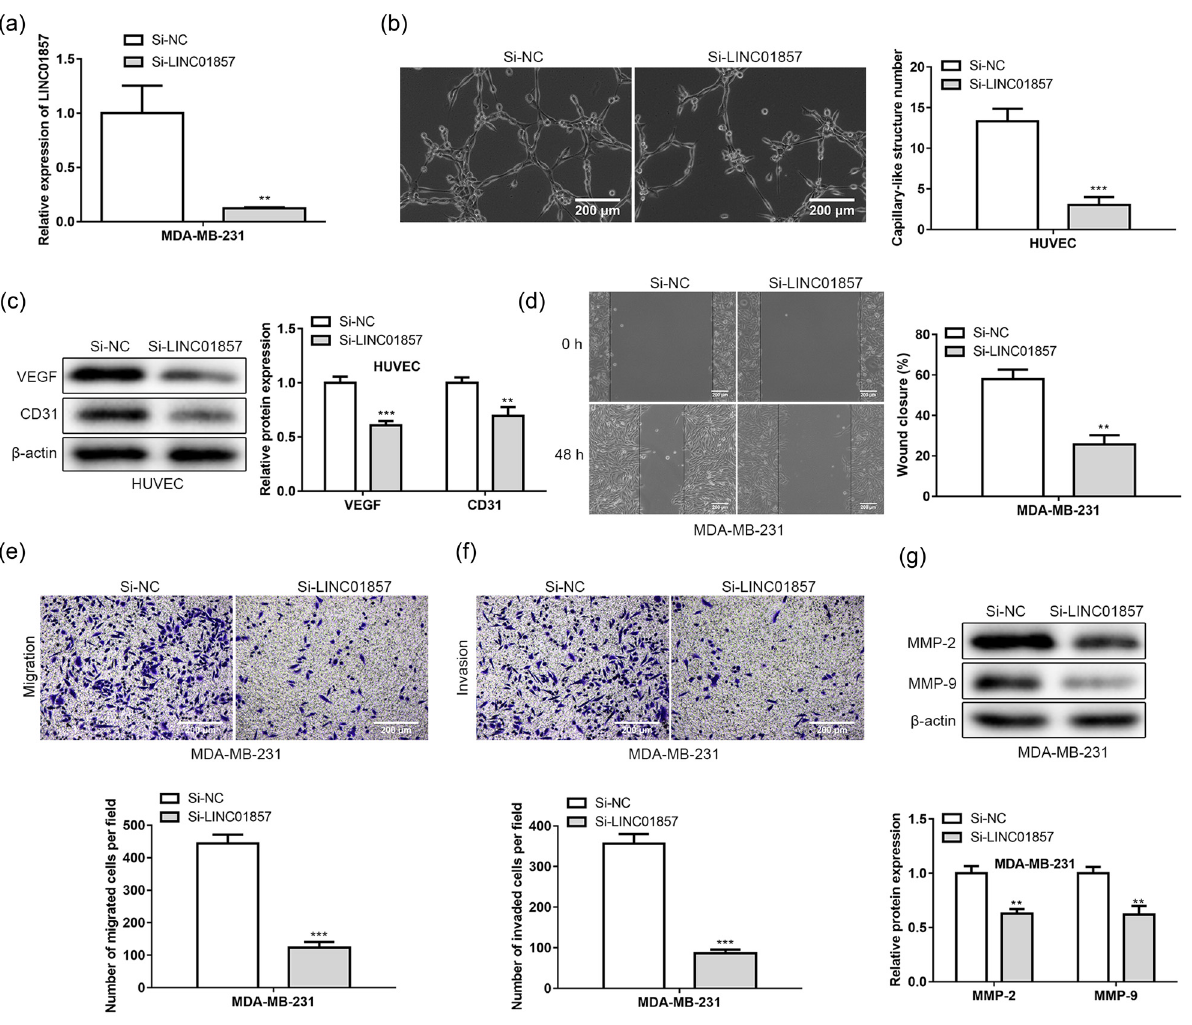
Figure 2: LINC01857 down - regulation inhibits metastasis of BC cells and angiogenesis of HUVEC: ( a ) qRT - PCR analysis was performed to evaluate the LINC01857 expressions in MDA - MB - 231 transfected with si - LINC01857; ( b ) angiogenesis experiment was used to evaluate the e ff ects of si - LINC01857 on the tube formation of HUVEC cells; ( c ) levels of angiogenesis - related proteins, including VEGF and CD31 in TCM - treated HUVEC cells, were evaluated by western blotting assay. The e ff ects of si - LINC01857 on MDA - MB - 231 cells metastasis were detected by ( d ) wound healing and Transwell, ( e ) migration, and ( f ) invasion analysis. ( g ) The levels of metastasis - related proteins, including MMP - 2 and MMP - 9 in MDA - MB - 231 cells transfected with si - LINC0185, were evaluated by western blotting assay. ** P < 0.01 and *** P < 0.001 vs si - NC